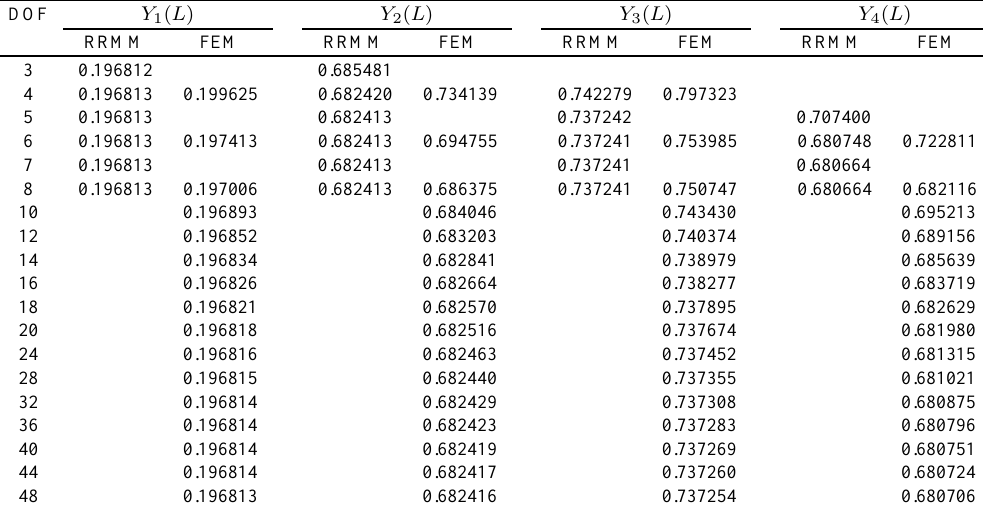
Table 3 Eigenfunction convergence at x =